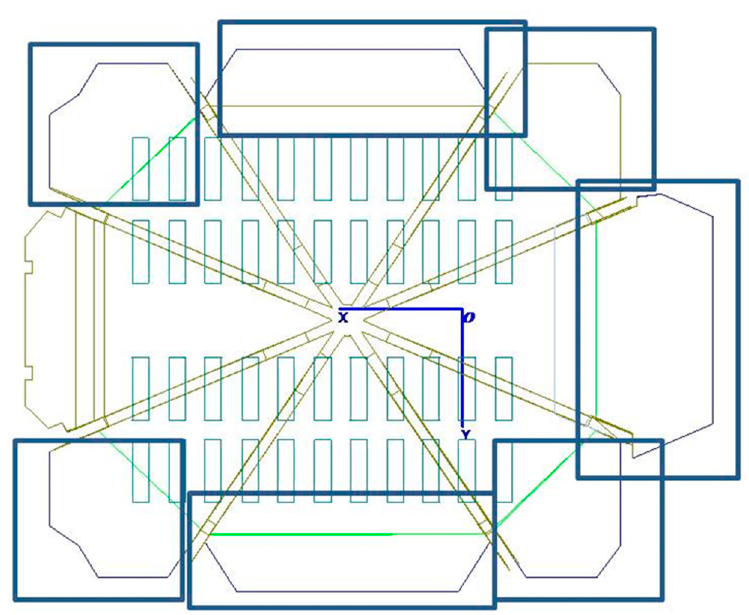
Figure 9. Lay-out of the absorbent materials, under lateral vaults. Table 4. Sound absorption coe ffi cient of the audience.